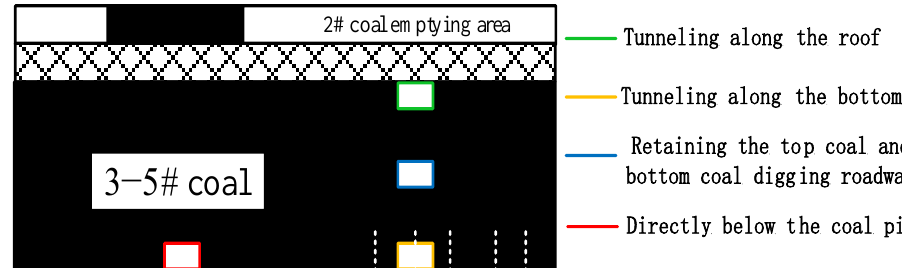
Figure 3. Schematic diagram of different roadway layout schemes.